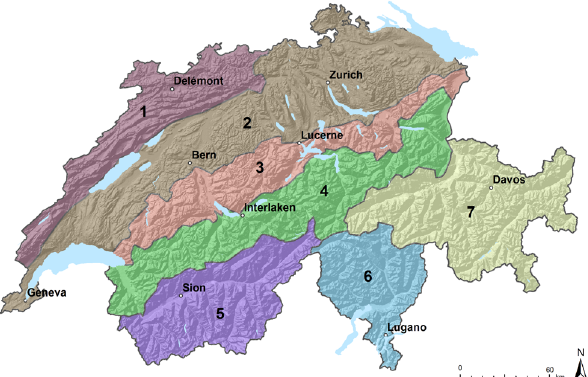
Fig. 1. Location of the seven subareas for which bedload da- mage data were aggregated according to Table 1 (1–Jura; 2– Swiss Plateau; 3–Prealps; 4–Central Alps; 5–Valais; 6–Ticino; 7–Grisons) displayed together with the digital elevation model of Switzerland (data: BFS GEOSTAT/Federal Office of Topography swisstopo). Note that these subareas do not necessarily correspond to cantonal